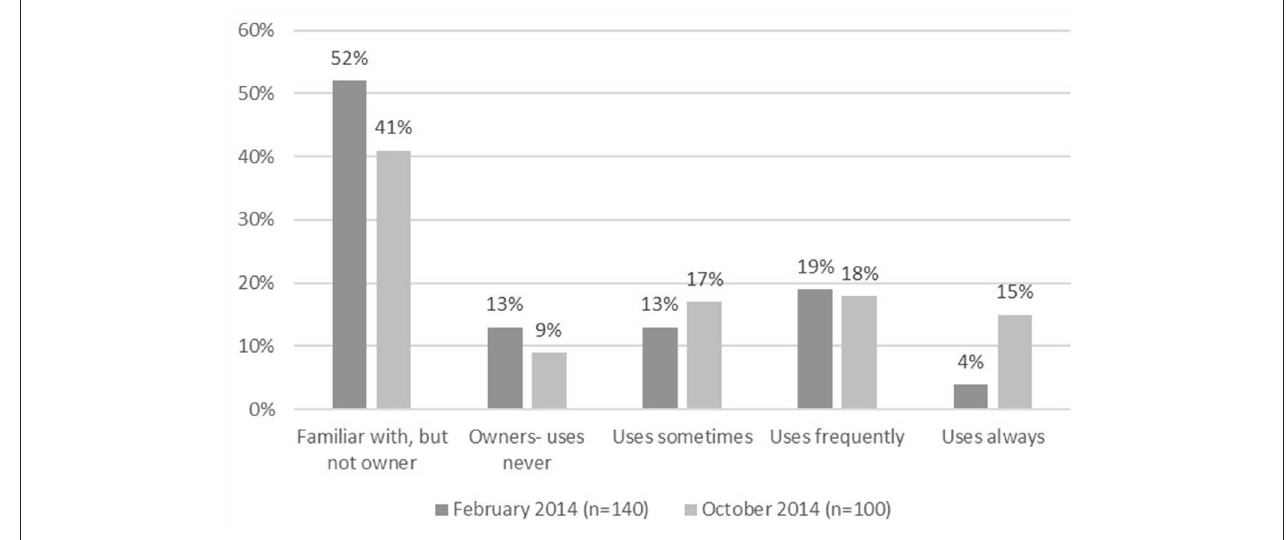
FIGURE 3 | Eetmaatje ownership and frequency of use, February and October 2014 (36).